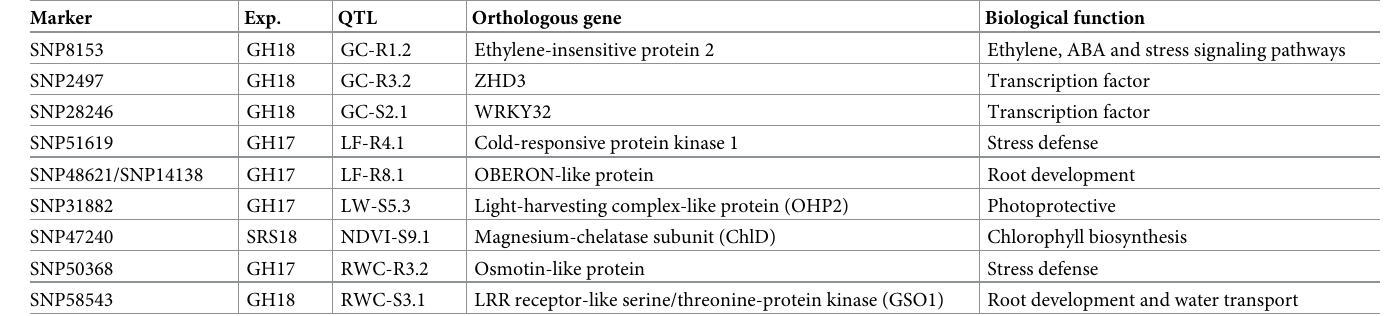
Table 4. Identification of candidate genes within QTL regions associated with drought tolerance. Sequences of SNP were aligned against NCBI database to searching orthologous genes with known function in other species. Marker